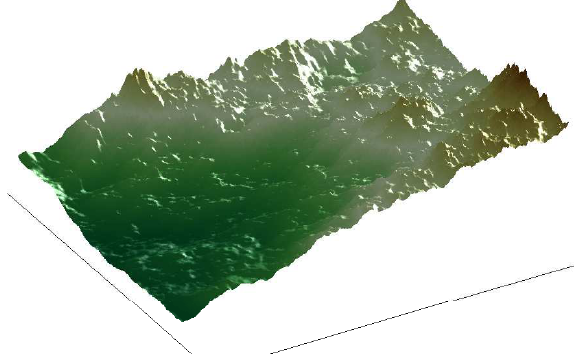
Fig. 2. A realisation of a bi-dimensional self-regulated multifrac- Fig. 2. A realization of a bi-dimensional self-regulated multifrac- tional process with g ( Z )=(1 − Z ) 2 tional process with g(Z) = ( 1 − Z) 2